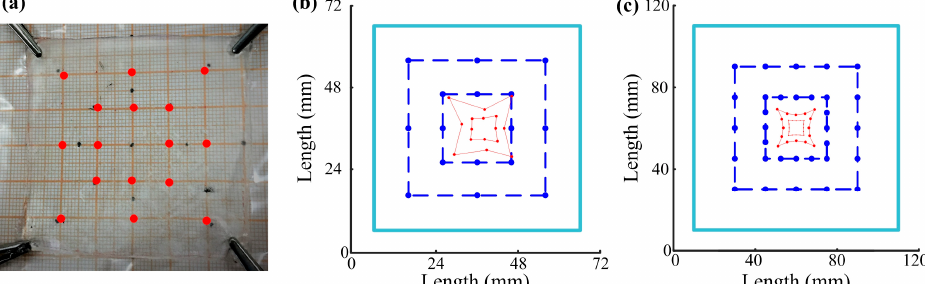
Figure 8. Touch locating of a square gel panel. ( a ) The touch panel with the touch locations indicated as red dots. ( b ) Sixteen points were touched on a square gel panel (60 mm × 60 mm) along two concentric squares (40 mm × 40 mm and 20 mm × 20 mm, respectively) and their locations were calculated according to Formula 9. ( c ) Thirty-two points were selected on a square gel panel (100 mm × 100 mm) along two concentric squares (60 mm × 60 mm and 30 mm × 30 mm, respectively) and their locations were simulated. Round dots represent individual points or locations, dark blue dashed lines connect touch or selected points, red lines connect calculated or simulated locations, and light blue lines indicate physical boundaries.